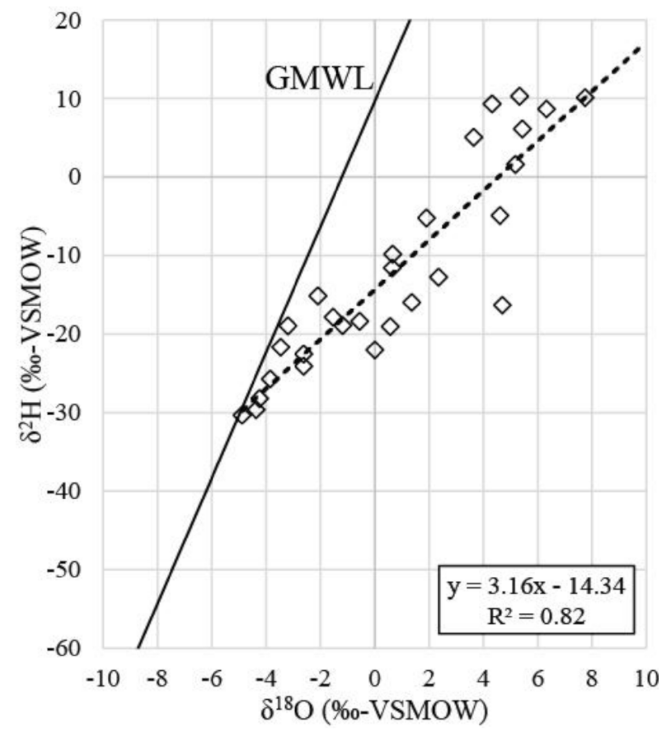
Figure 8. δ 18 O and δ 2 H values for water samples collected by the NPS from tinajas during March and April 2011